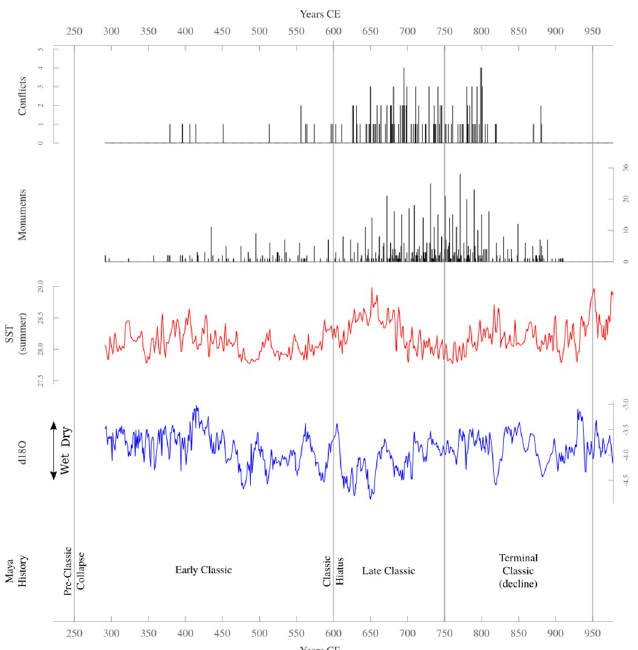
Fig 2. Time-series data and Classic Maya